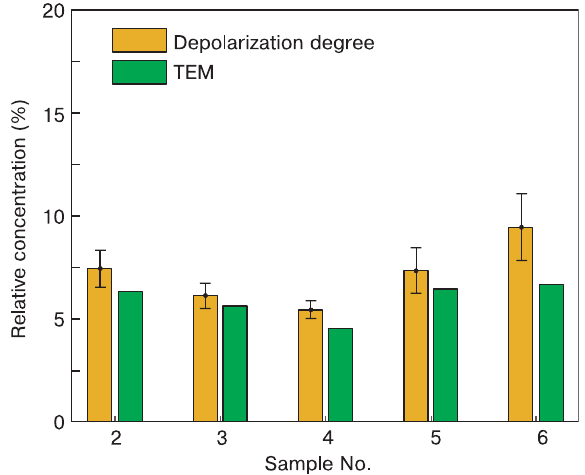
Figure 5 . Relative concentration of quasispherical impurities as per depolarization degree and TEM measurements. circle while k close to zero is the case for elongated par- c ticles.